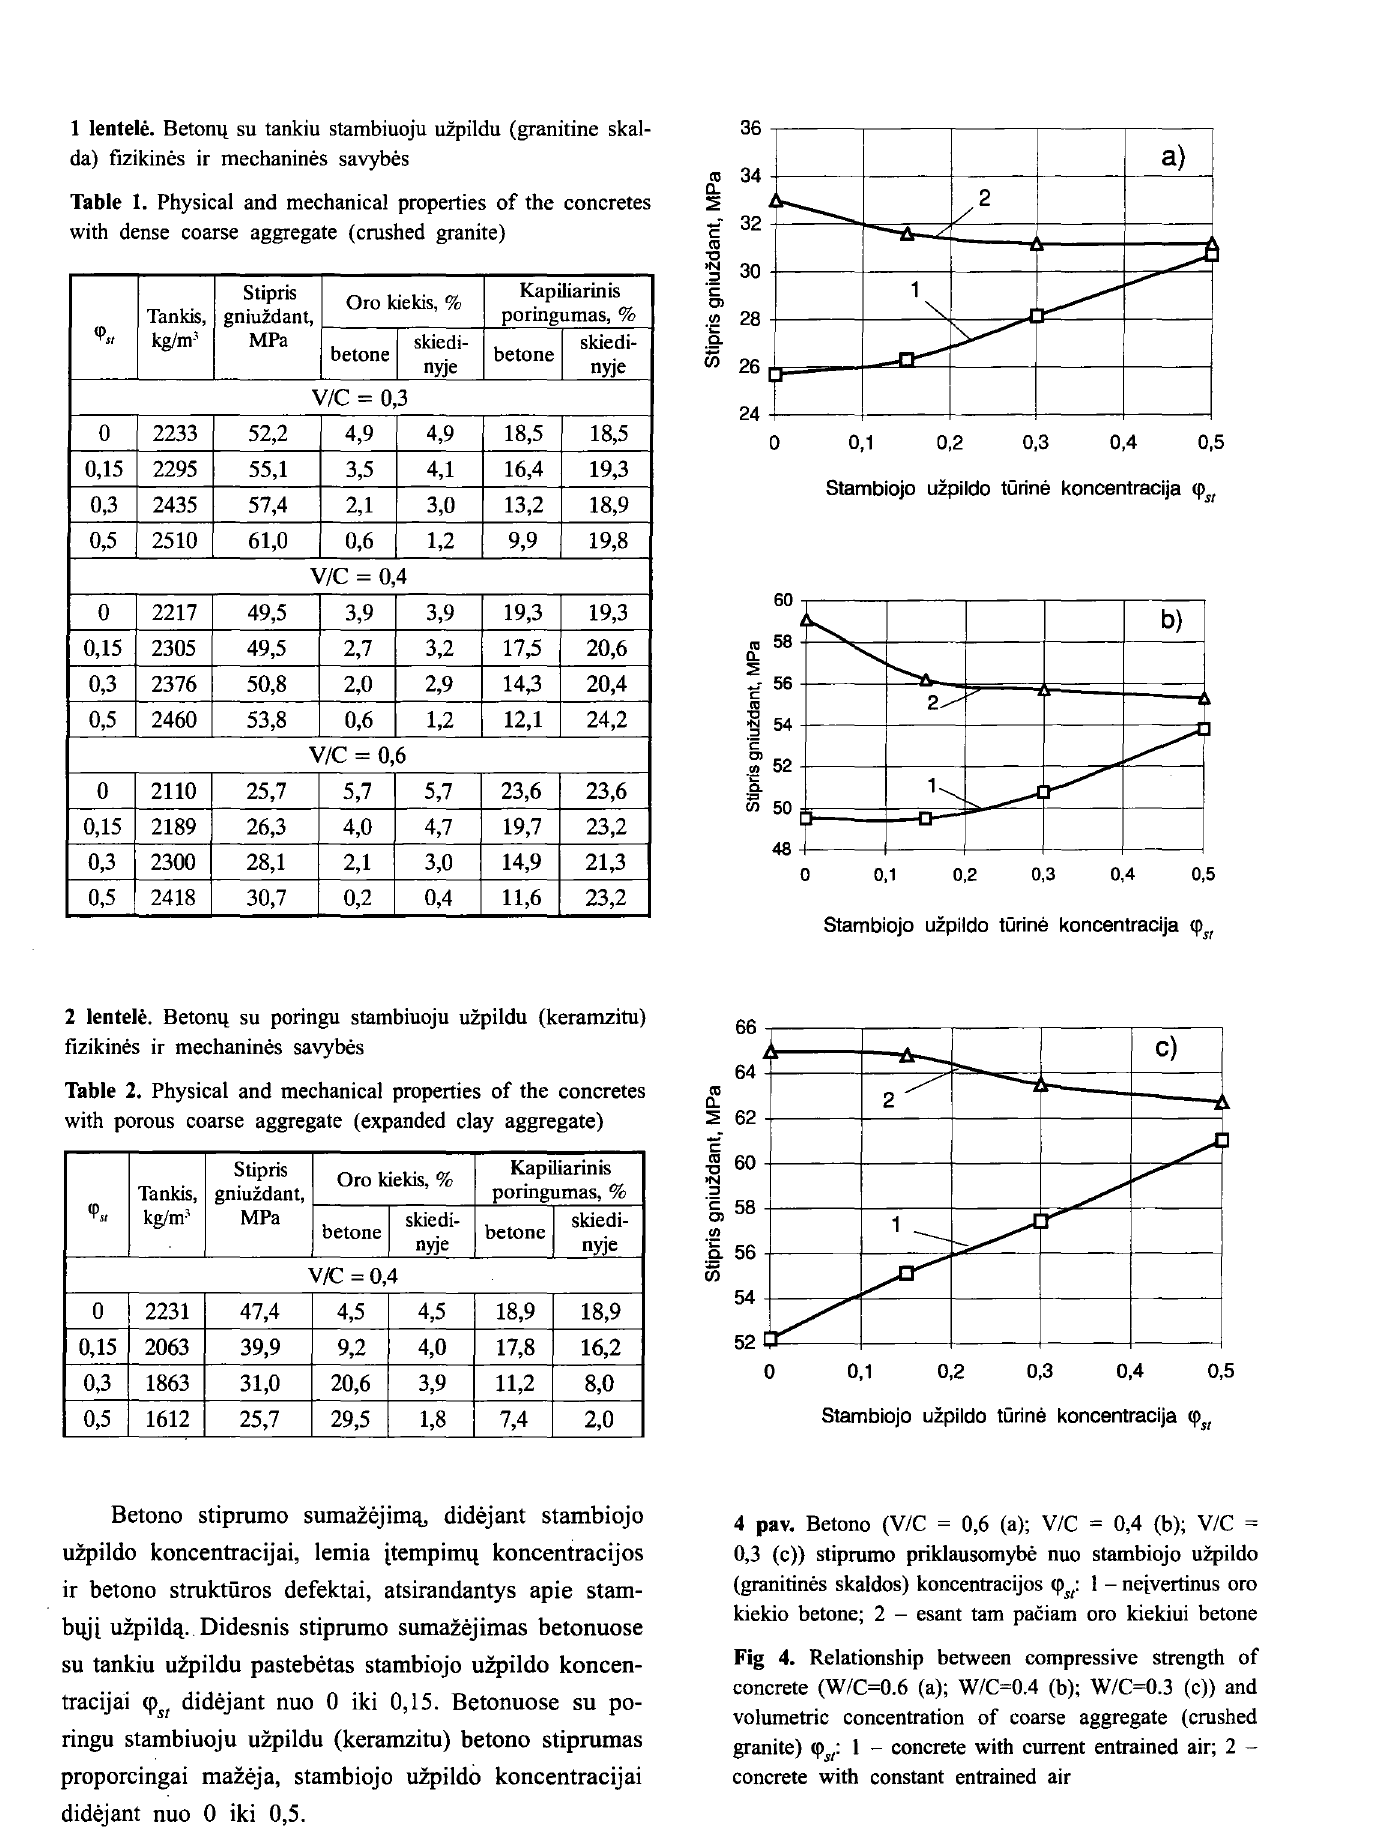
Fig 4. Relationship between compressive strength of concrete (W/C=0.6 (a); W/C=0.4 (b); W/C=0.3 (c)) and volumetric concentration of coarse aggregate (crushed granite) lf>s 1: l - concrete with current entrained air; 2 - concrete with constant entrained